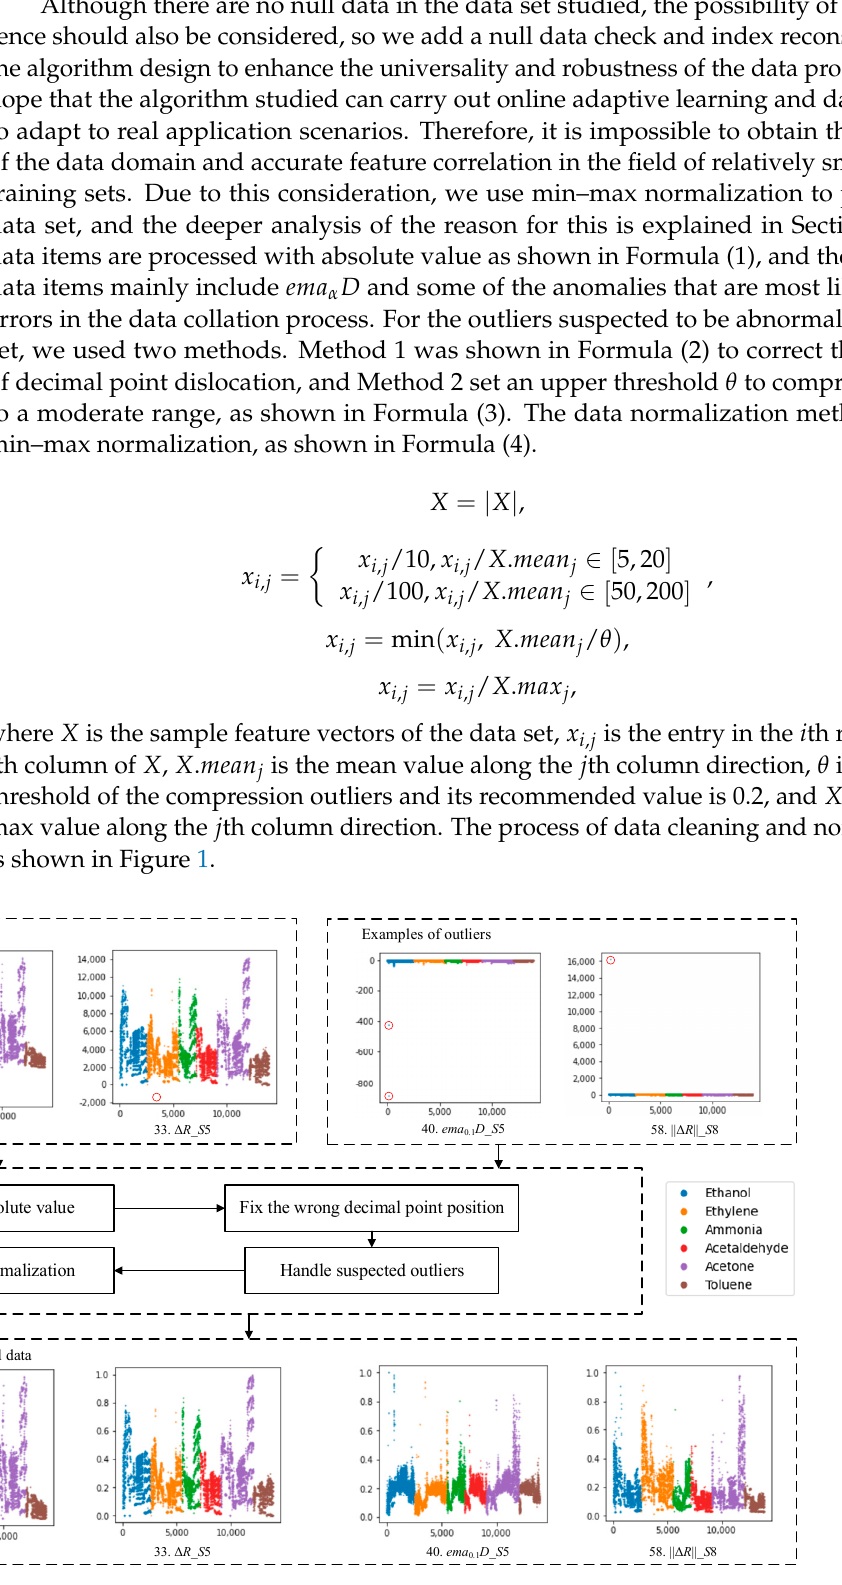
Figure 1. The process of data cleaning and normalization.